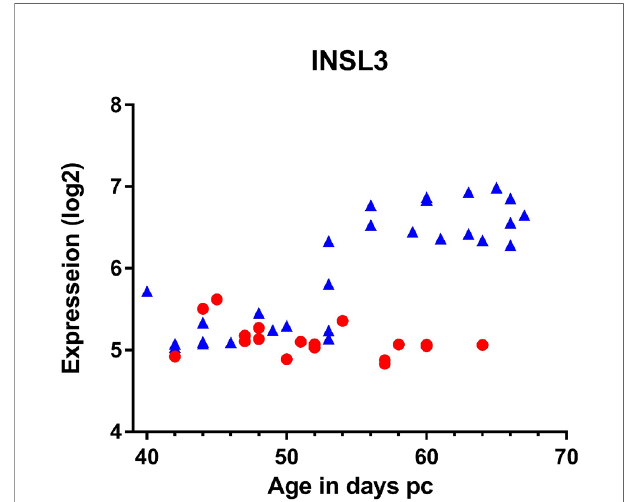
FIGURE 2 | Expression of INSL3 mRNA measured by microarray analysis of gonadal tissue derived from individual male (blue triangles) or female (red circles) human fetuses at the ages indicated